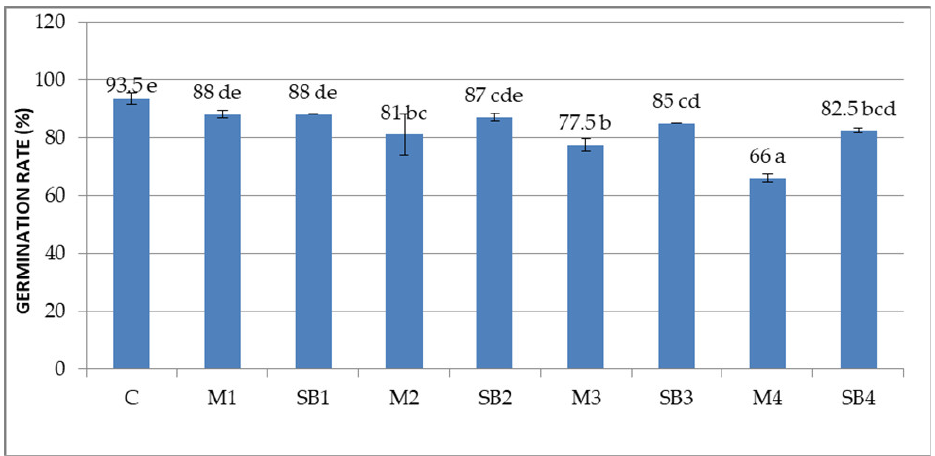
Figure 1. Germination rate of Triticum aestivum grains after 48 h of incubation with grape marc extracts. Different letters (a–e) denote significant differences, p < 0.05.